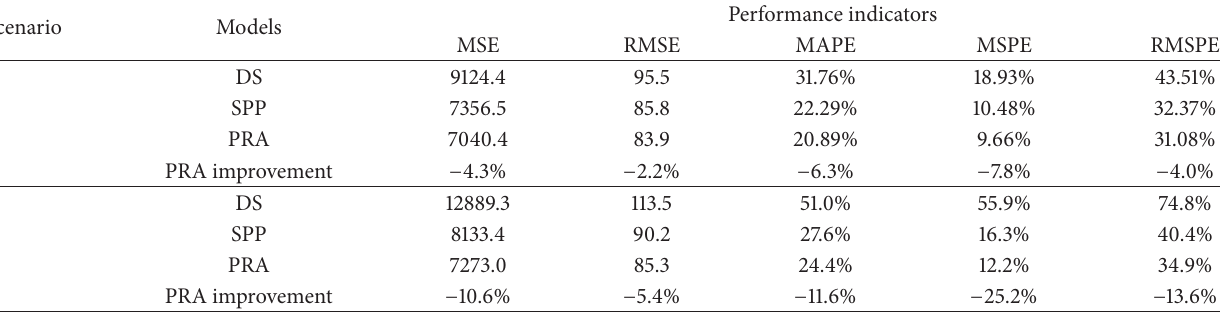
Table 4: Estimation accuracy of link flow counts.